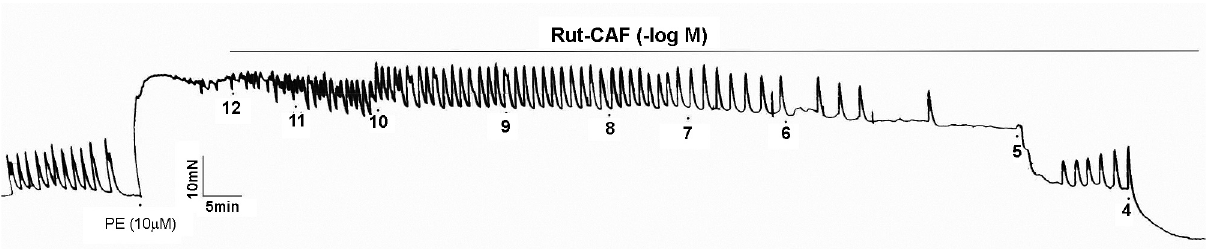
Figure 5 – Physiographic tracing of the Rut-CAF (10 -12 - 10 -4 M) effect in human corpus cavernosum strips placed in Kreb-Henseleit (37ºC; pH 7.4, 95% O and 5% CO ) solution, under a 1g tension and pre-contracted with phenylephrine. 2 2 Vertical scale = 10 mN and horizontal scale = 5